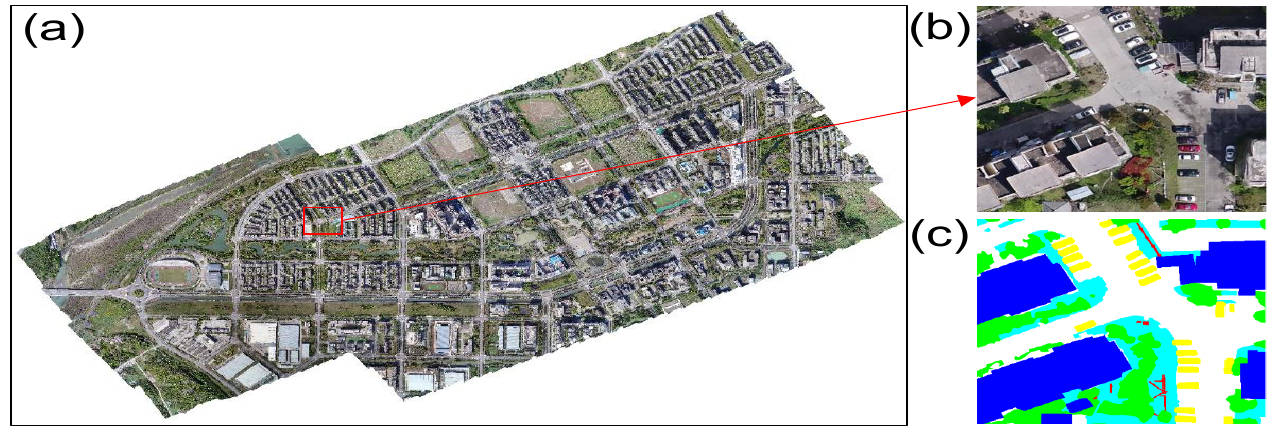
Figure 3. Overview of the BC403 dataset ( a ). True orthophoto with a size of 768 × 768 ( b ) and its semantic labels ( c